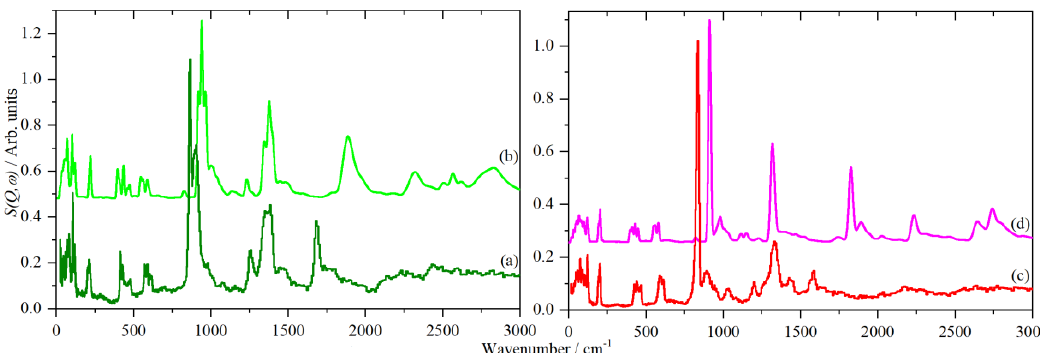
Figure 1. Raman spectra of CsHSO 4 in: phase III at ( a ) 10 K and ( b ) at 290 K, phase II at ( c ) 10 K and ( d ) at 300 K and phase I ( e ) at 430 K.